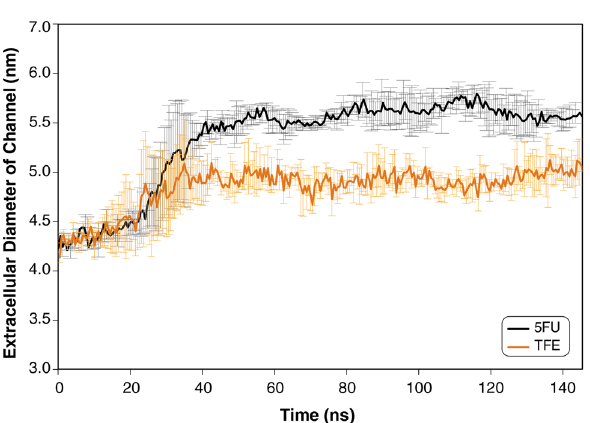
Figure 4. Effect of 5-FU and TFE on MscL conformation. Extracellular diameter of MscL increases when added 5-FU and TFE are added from the extracellular side. 5-FU exerted a larger effect on MscL conformation compared to TFE. Data represents mean ± SD of 3 replicate